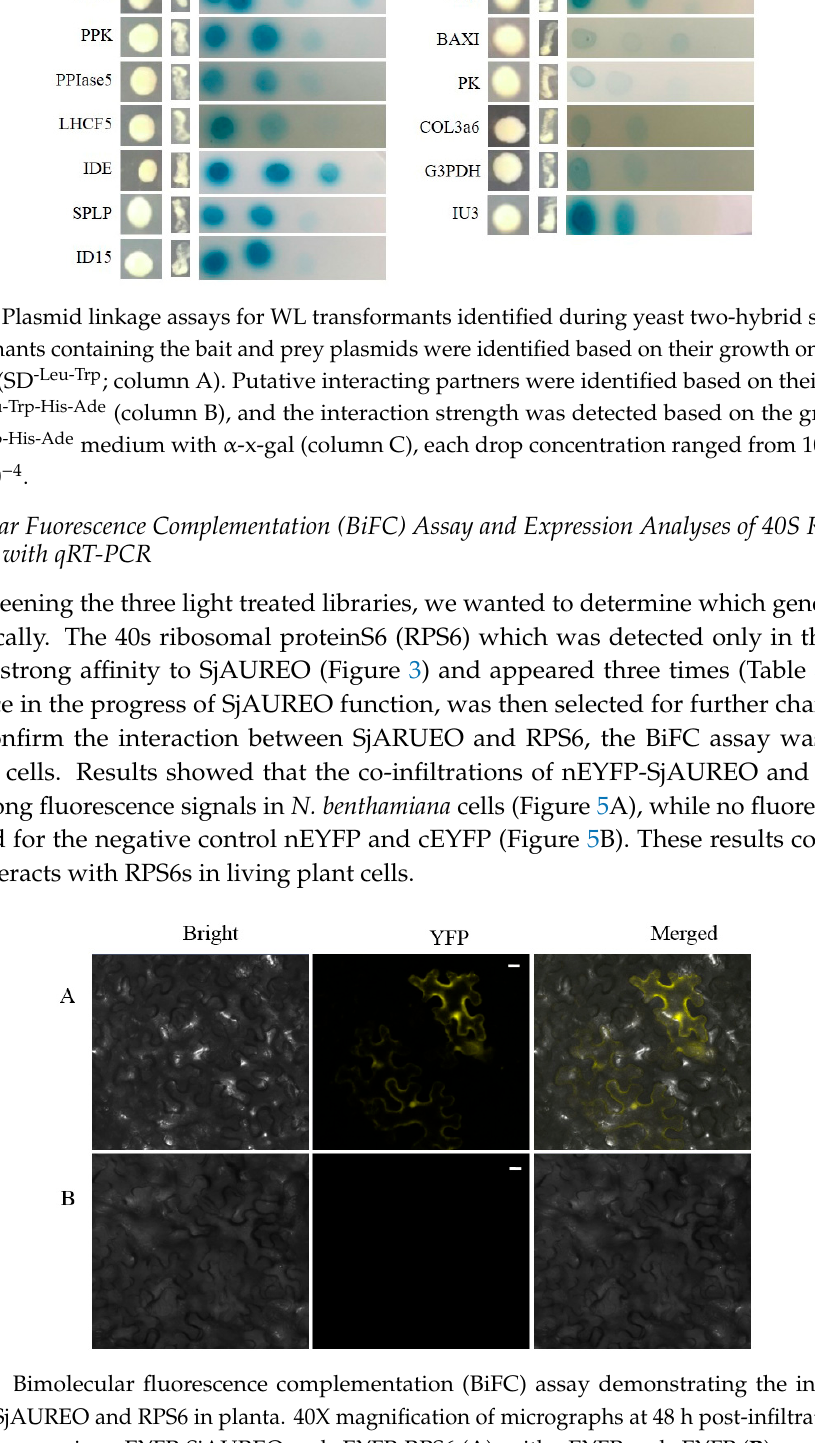
7 of 13 Figure 3. Plasmid linkage assays for BL transformants identified during yeast two-hybrid screening. Transformants containing the bait and prey plasmids were identified based on their growth on dropout medium (SD -Leu-Trp ; column A). Putative interacting partners were identified based on their